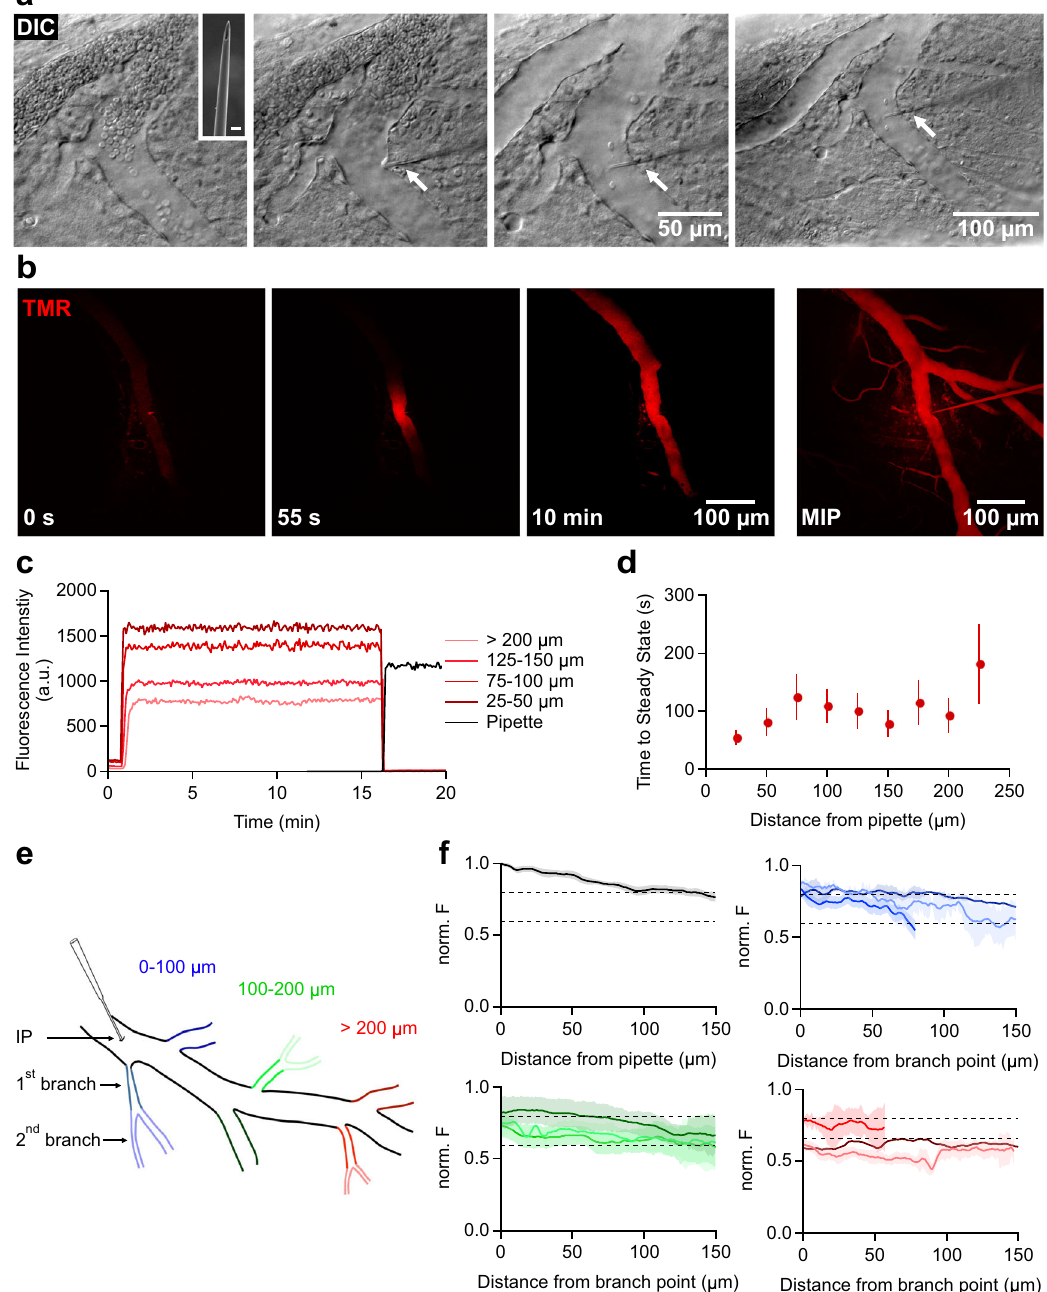
Fig. 1 | Micro-pipette-based perfusion of capillaries provides control of the composition of the luminal solution and pressure. a Representative light microscopic (differential interference contrast, DIC) images showing the penetra- tionofavesselwithaglasscapillary(4experiments).Arrowpointstowardthetipof the pipette. Inset: raster electron micrograph of the beveled tip (scale bar 5 µ m). Also see Suppl. movie 1 illustrating the fl ushing of the vascular lumen. b 2P-scans representative of at least 15 experiments. MIP; maximum intensity projection. c Intravascular fl uorescence. Numbers denote the distance of the measurement from the point of impalement. d Luminal steady-state tracer concentration, as assessed by fl uorescence measurements, are reached within ~100s. Data obtained from 15 injections/9 animals; number of assessed ROIs: n IP =15; n 0 – 25 μ m =15;